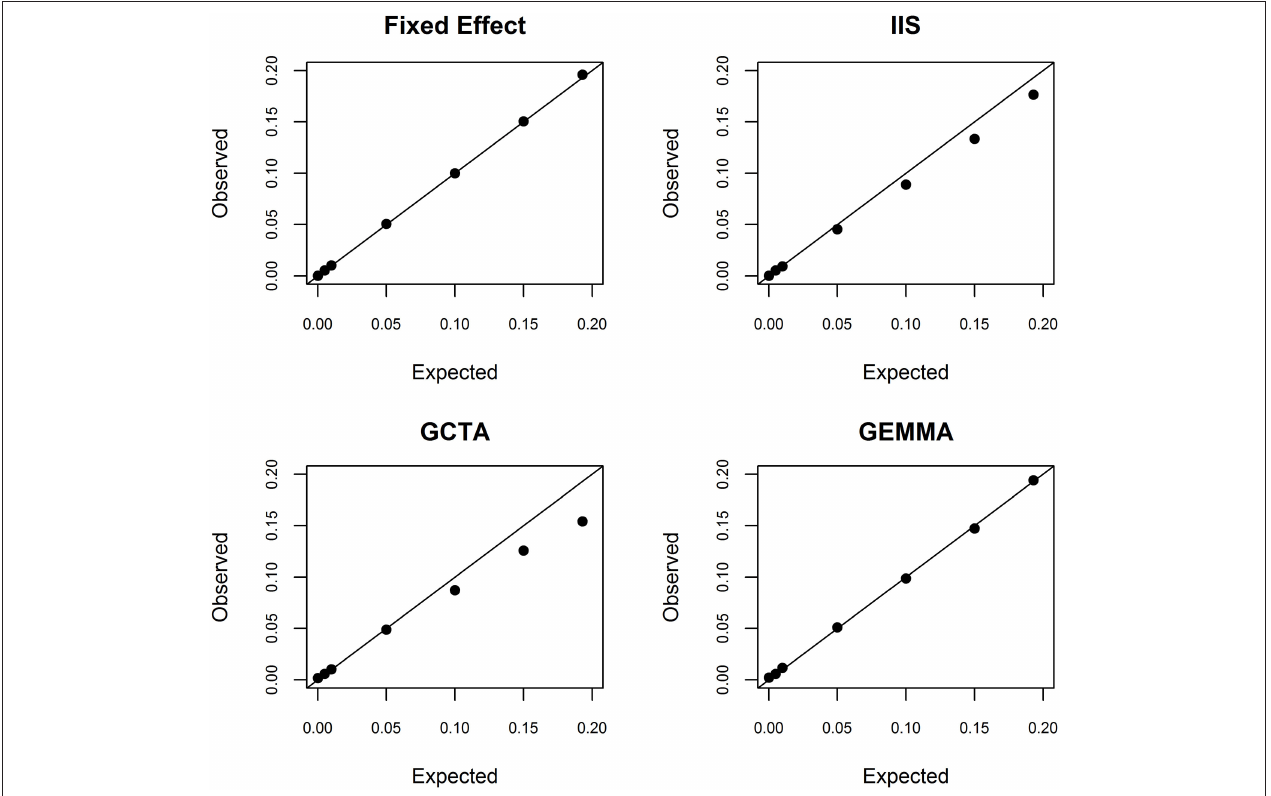
FIGURE 2 | Simulation study of bias in the random effects model. Conditional on local ancestry at rs2814778, we simulated a continuous phenotype with a known proportion of phenotypic variance explained by a single causal locus and the remainder of the phenotypic variance being random noise. We randomly generated 100 independent data sets. We then used the fixed effects model (top left), ancestral similarity defined by identity in state (top right), centered and scaled ancestral similarity as defined by GCTA (bottom left), and centered ancestral similarity as defined by GEMMA (bottom right) to estimate the proportion of phenotypic variance explained by local ancestry using similarity estimated